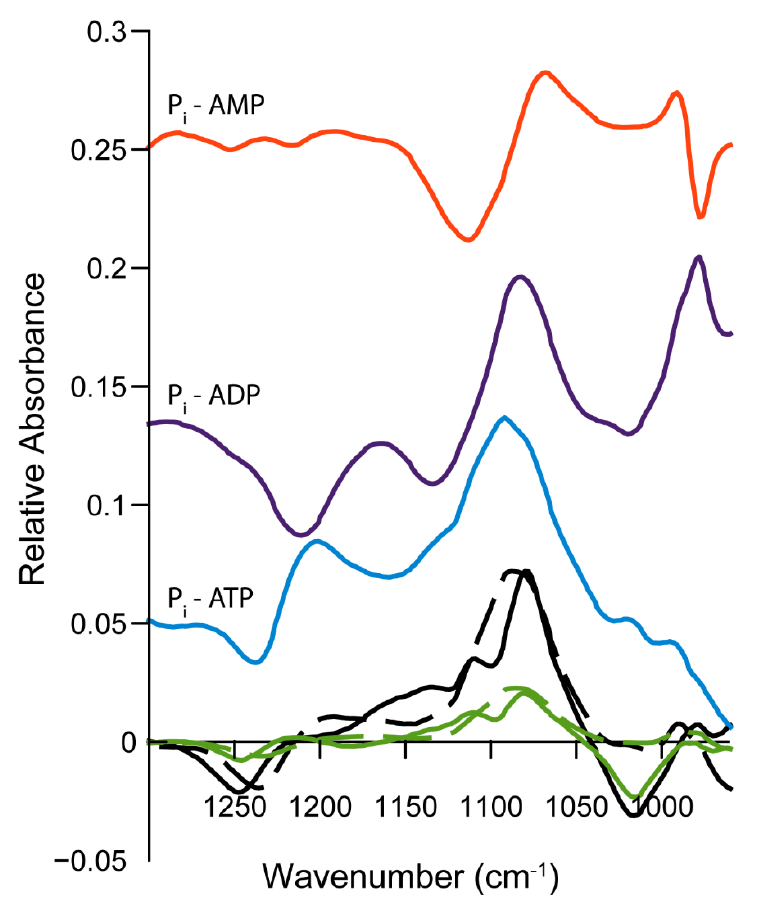
Figure 6. IR difference spectra of 50 mM of the nucleotides and of the extracellular medium containing 50 mM ATP extracted from MOVAS after 14 days of incubation in osteogenic medium. Orange: IR difference spectrum P i minus AMP; violet: IR difference spectrum AMP + P i minus ADP; blue: IR difference spectrum ADP + P i minus ATP; Full black line: IR difference spectrum at 48 h minus 3 h; dashed black line: best fit; Full green line: IR difference spectrum at 24 h minus 3 h; dashed green line: best fit.